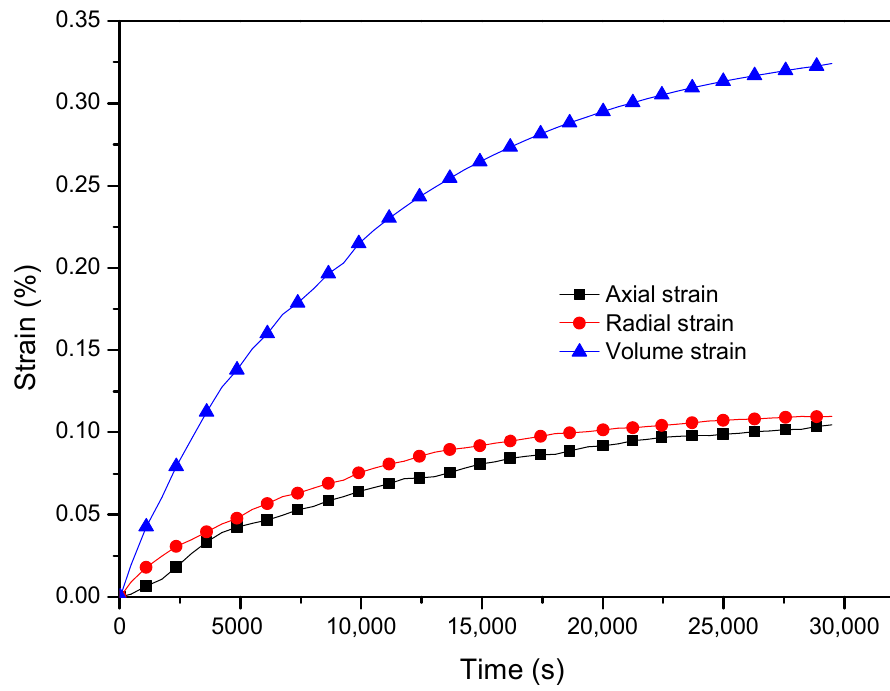
Figure 5. Variation of adsorption strain of coal sample under loading with time at 283.15 K.